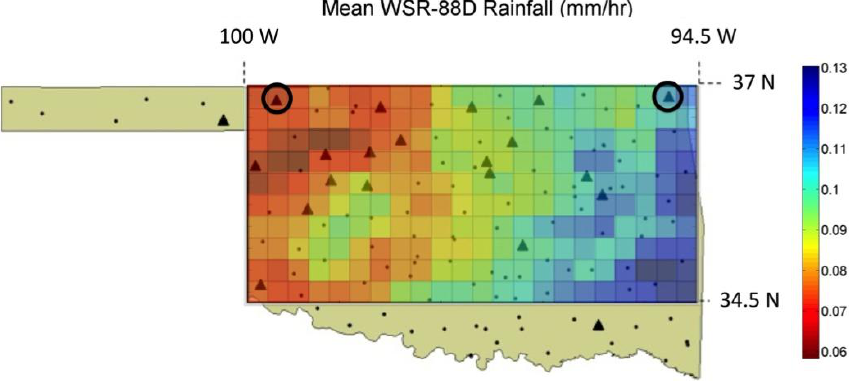
Fig. 1. Map of 3-yr (2004–2006) average rainfall, overlaid by a 25km grid covering the experiment domain and locations of OK Mesonet stations (black dots). The triangular symbols represent Mesonet stations where sufficient soil moisture observations are available at four different depths during the study period. Black circles highlight two locations for which soil moisture time series are shown in Sect. 4. This figure corrects for a mistake in Fig. 1b of Maggioni et al. (2011).